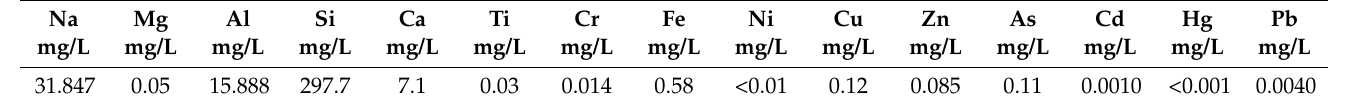
Table 2. Solution’s composition. Table 2. Solution's composition.